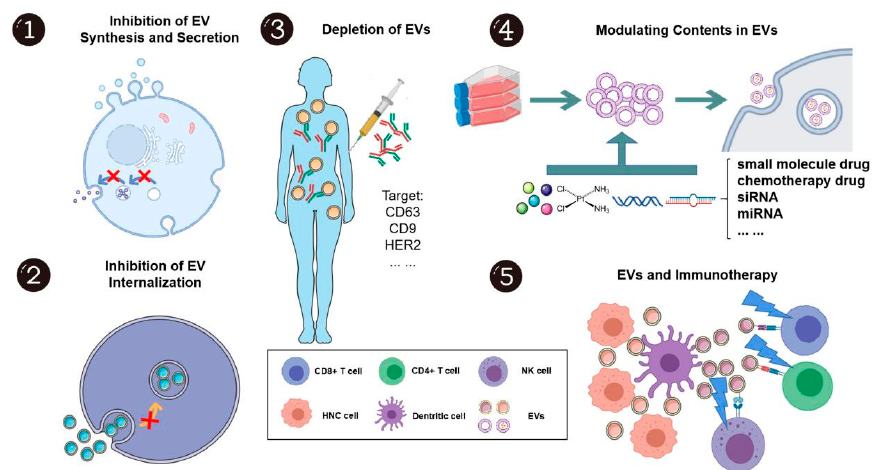
Figure 5. The potential applications of extracellular vesicles in head and neck cancer treatment. EVs show great potential as both treatment targets and drug carriers. As EVs can promote head and neck cancer development and progression, inhibition of synthesis, secretion, internalization, and even the depletion of EVs, to some extent, may elicit anti-cancer e ff ects. Further, EVs are unique in that they